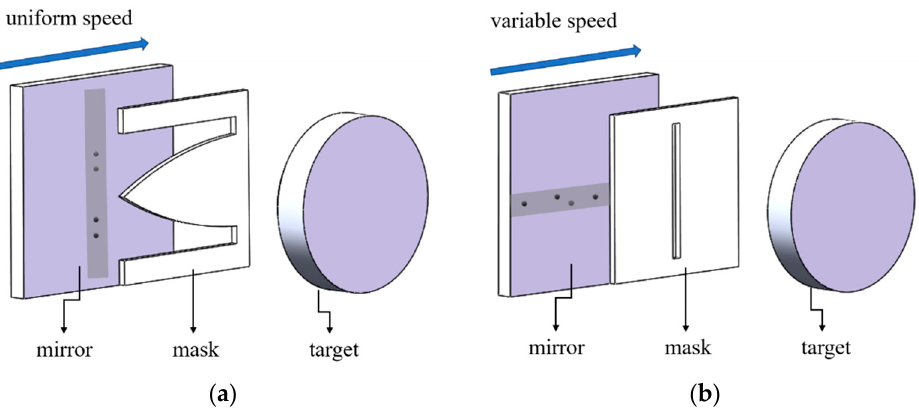
Figure 1. Mask-assisted magnetron sputtering: ( a ) profile-coating, ( b ) differential-deposition.